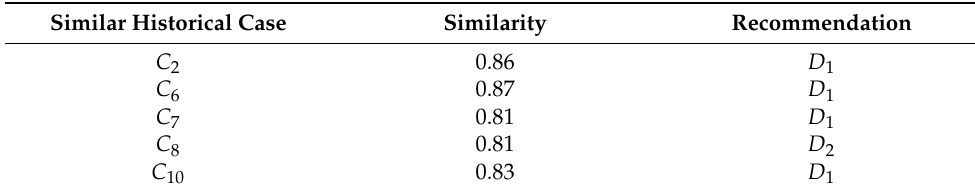
Table 7. Similar historical